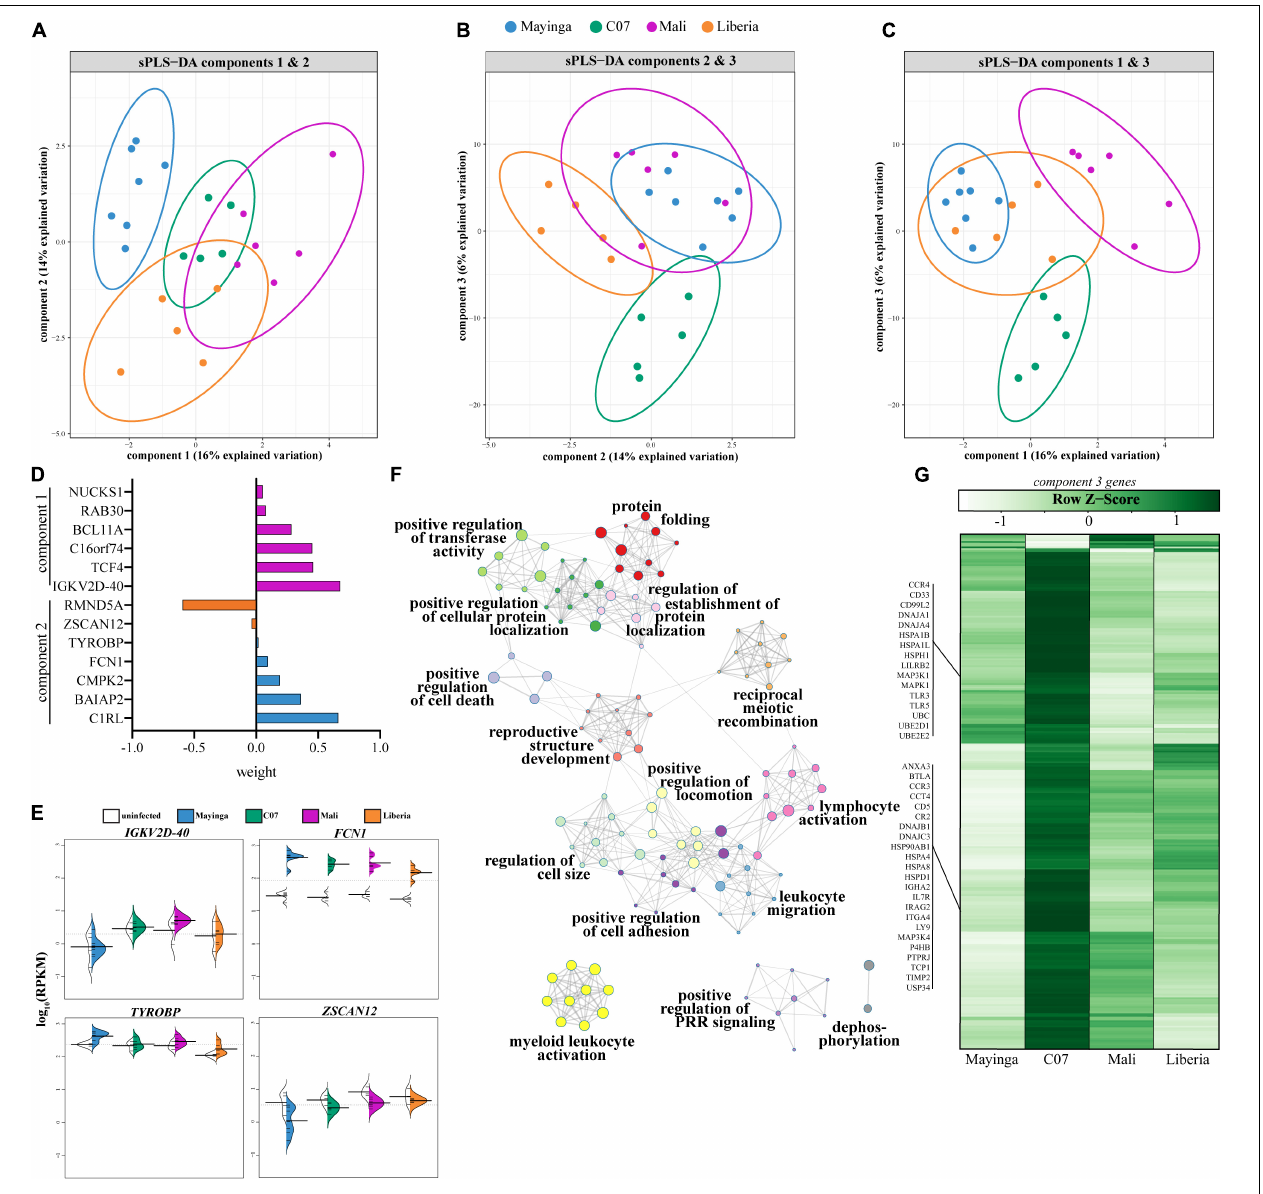
FIGURE 6 | Genes regulating immune and stress responses are sufficient to distinguish EBOV infections. (A–C) Plots depicting the three components contributing the most to the variation amongst infected animals at 4 and 6 DPI as determined by sparse partial least squares discrimination analysis (sPLS-DA). (D) Weight loadings of genes belonging to components 1 and 2 as identified in panels (A–C) . (E) Beanplots illustrating expression (log10RPKM) of genes from panel D. (F) Gene ontology (GO) network depicting functional enrichment of 290 genes of component 3. Clusters of closely related GO terms are labeled with the most significant GO term. Node size represents the number of genes associated with the GO term. Gray lines represent shared interactions between GO terms, with density and number indicating the strengths of connections between closely related GO terms. (G) Heatmap representing the 290 genes of component 3. Each column represents the average rpkm values of the indicated group across 4 and 6 DPI. Range of colors is based on scaled and centered rpkm values of the represented